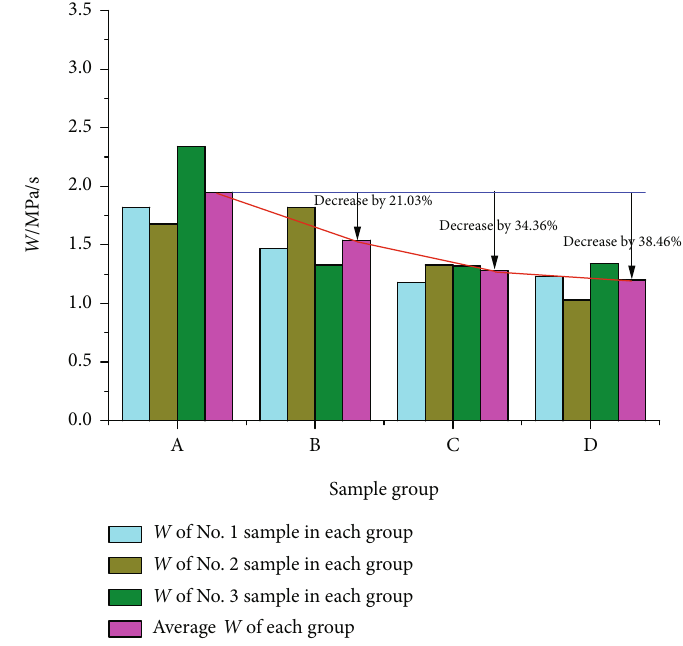
Figure 8: Comparison of sandstone sample W